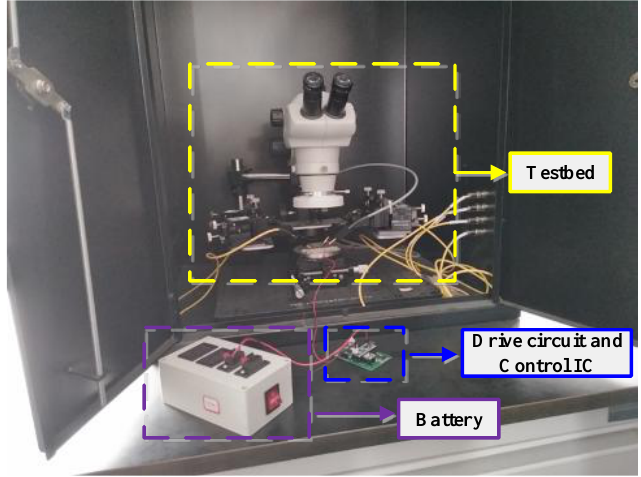
Figure 19. Image of the entire system.